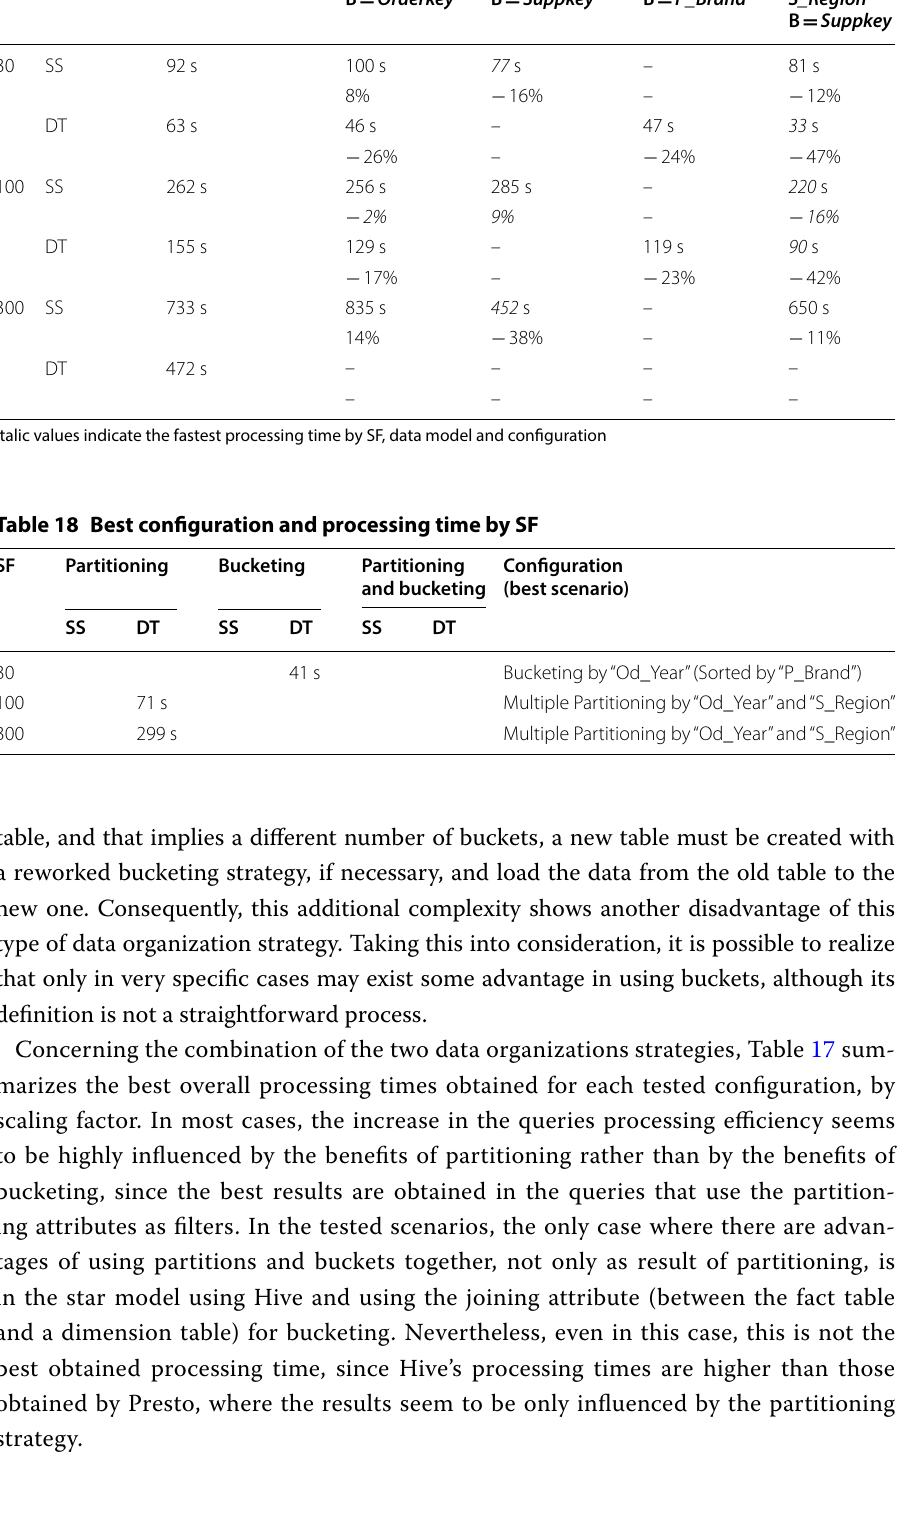
Table 17 Best results by partitioning and bucketing configuration and by SF